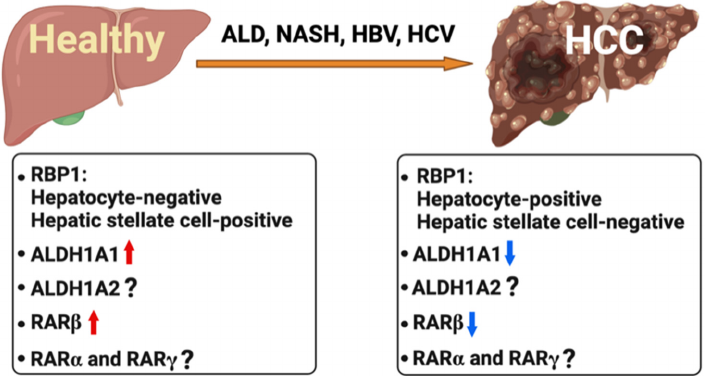
Figure 3. Retinoids and hepatocellular carcinoma (HCC). Alcohol-related liver disease (ALD), non- alcoholic steatohepatitis (NASH), and hepatitis virus B and C infection (HBV and HCV) predisposes to the development of HCC. While there is strong evidence that in healthy liver RBP1 (retinol bind- ing protein 1) is expressed predominantly in hepatic stellate cells rather than in the hepatocytes, in HCC RBP1 expression is lost in hepatic stellate cells and observed in hepatocytes. ALDH1A1, which is one of the enzymes responsible for the conversion of retinaldehyde to retinoic acid, is lower (blue downward arrows) in HCC than in healthy liver (red upward arrows). Lower RAR β levels com- pared with adjacent non-tumor and healthy livers also characterize HCC. There is limited research on RAR α and γ in